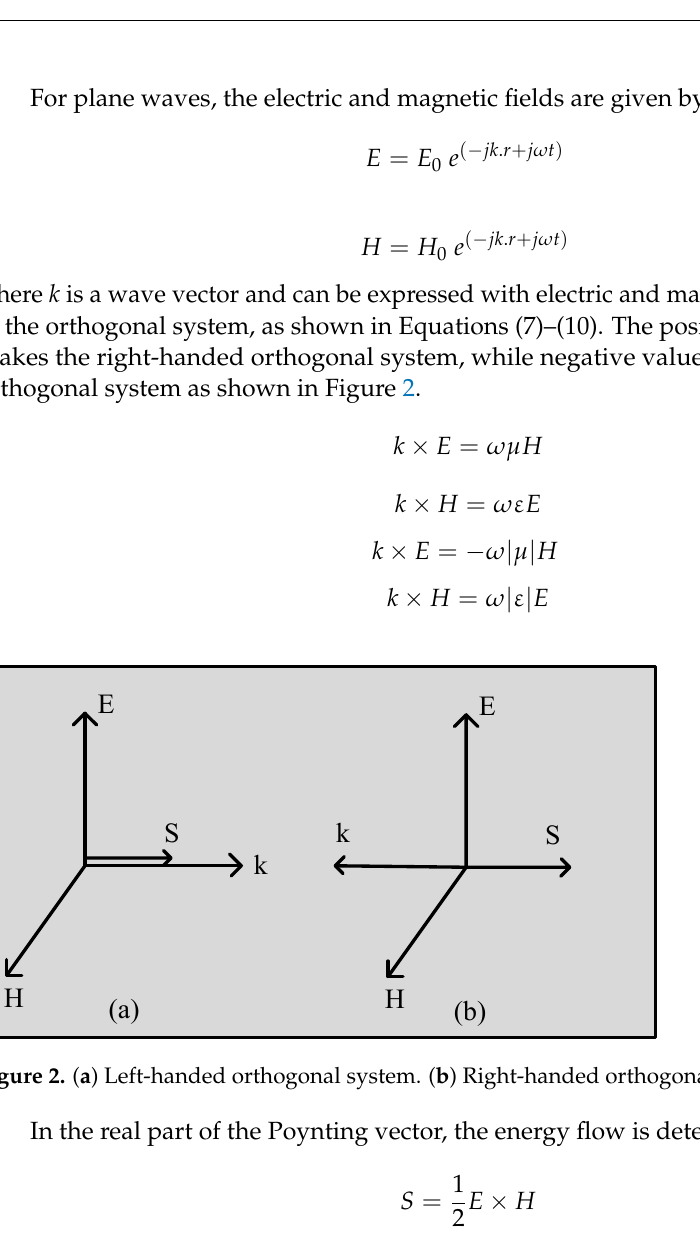
Figure 2. ( a ) Left-handed orthogonal system. ( b ) Right-handed orthogonal system.